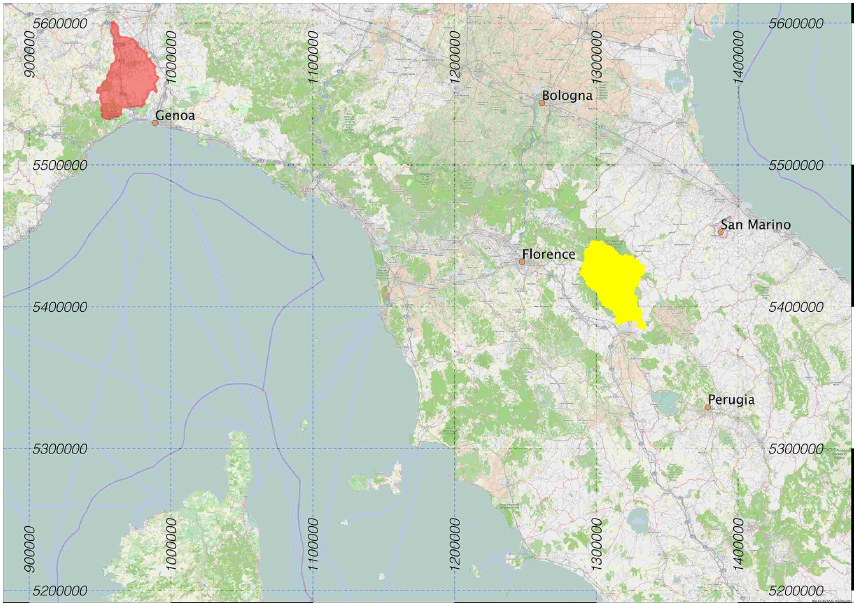
Figure 2. Location of the study areas. The Orba basin (in red) in the north-west of Italy and the Casentino basin (in yellow) in central